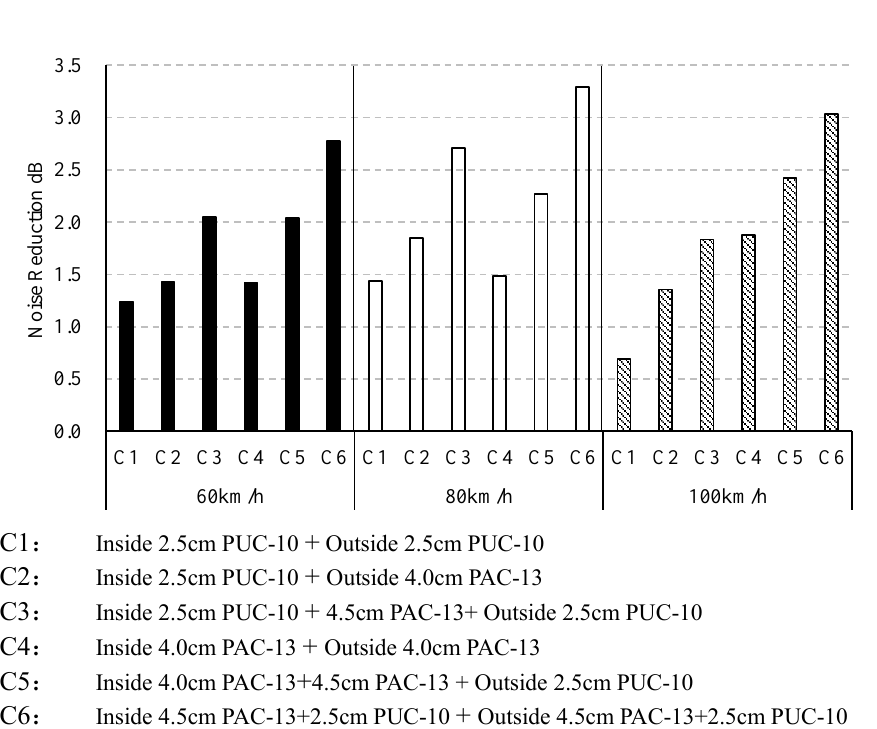
Figure 10: Noise reduction effect of composite pavement at same speeds. Figure 10. Noise reduction effect of composite pavement at same